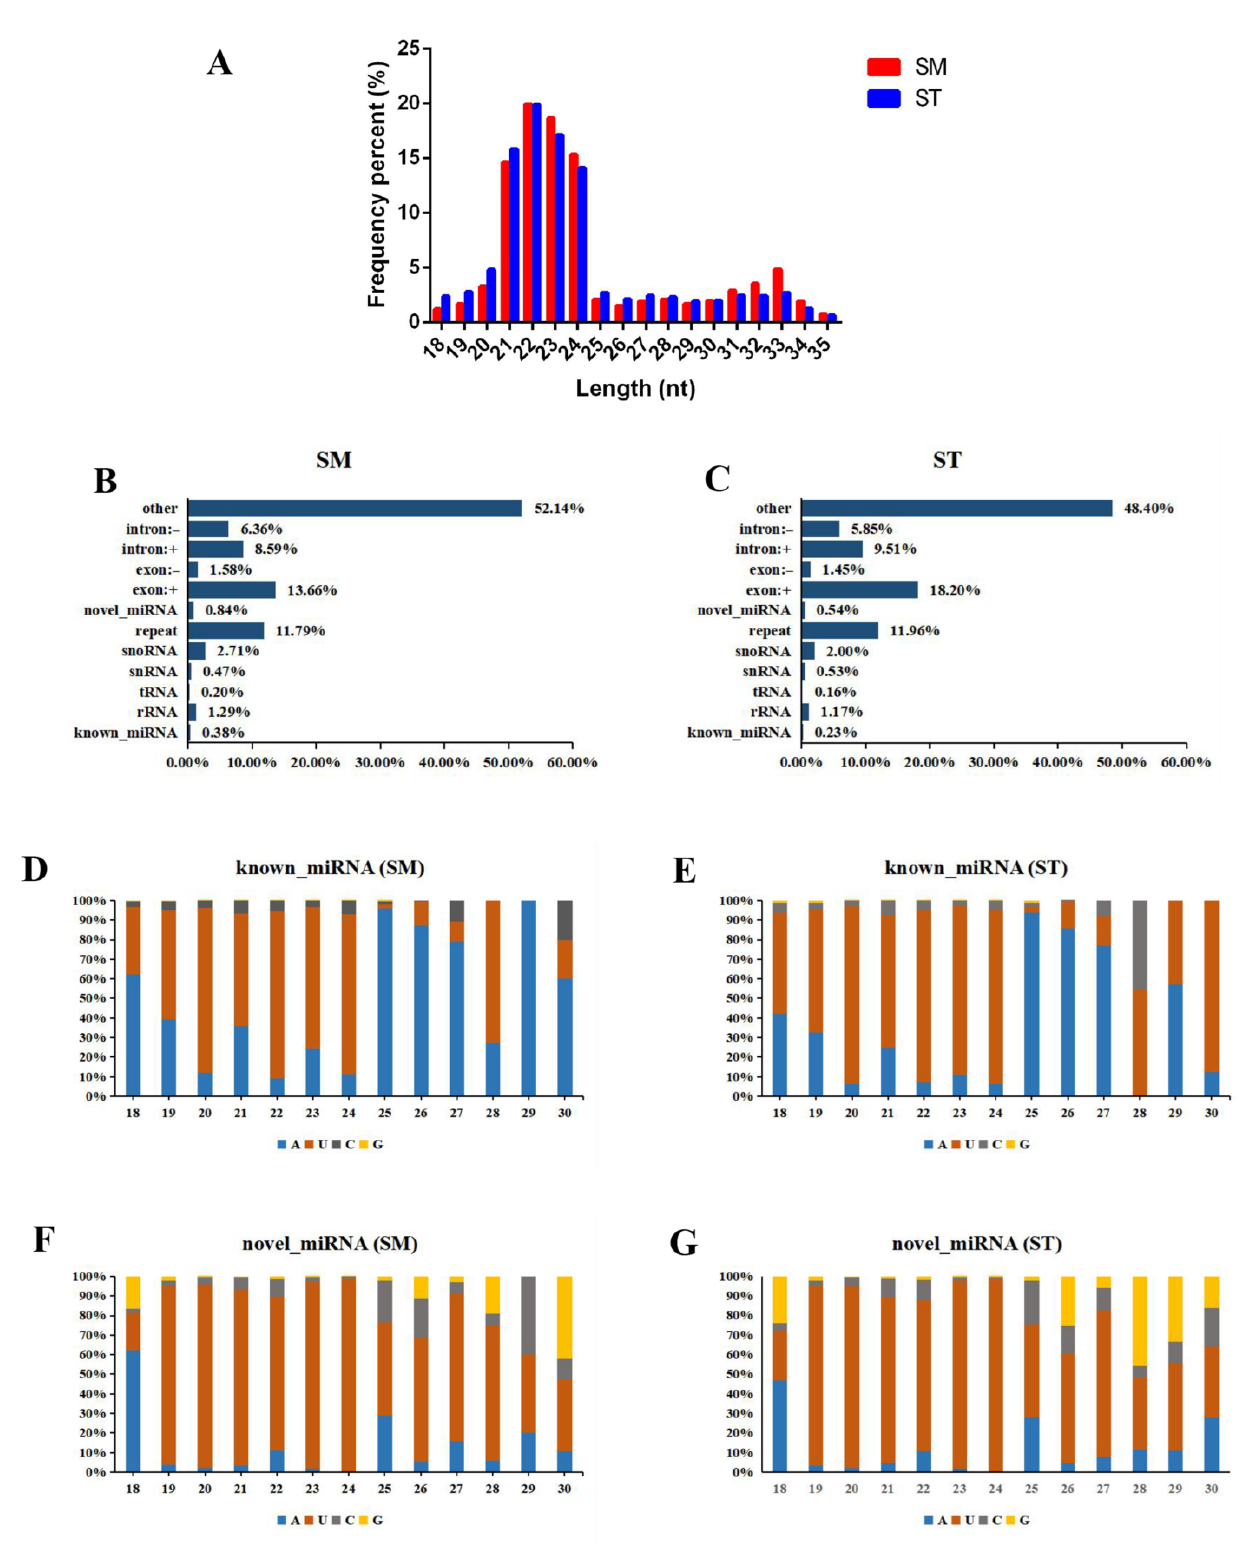
Figure 2. Identification and characterization of miRNA. ( A ) Length distribution of total sRNA fragment. ( B ) Classified identification of all sRNA in small waves. ( C ) Classified identification of all sRNA in straight wool. ( D ) First base preference analysis of known miRNA in small waves. ( E ) First base preference analysis of known miRNA in straight wool. ( F ) First base preference analysis of novel miRNA in small waves. ( G ) First base preference analysis of novel miRNA in straight